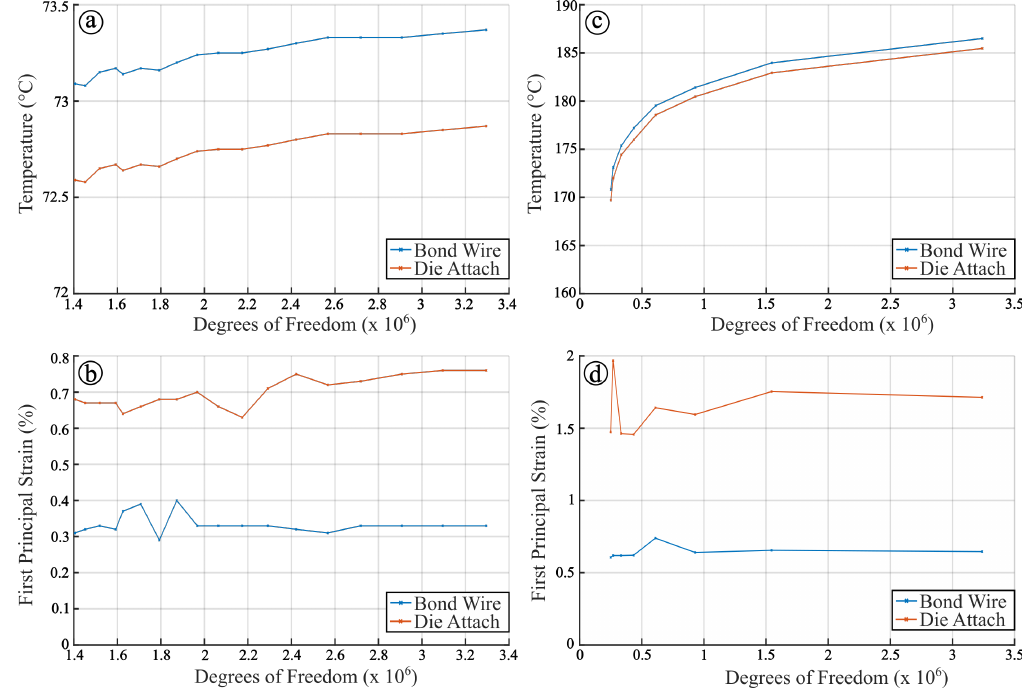
Figure 9. Convergence plots of the ( a , c ) temperature and the ( b , d ) first principal strain of the cascode GaN MOSFET and the SiC MOSFET